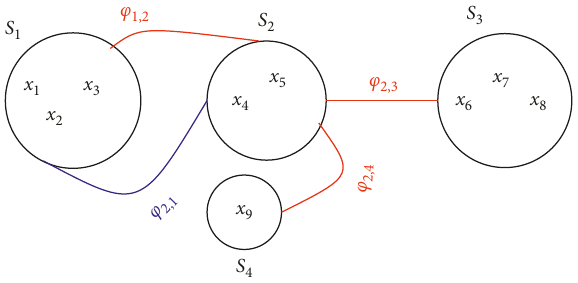
Figure 1: Superhypergraph H � ( X, S